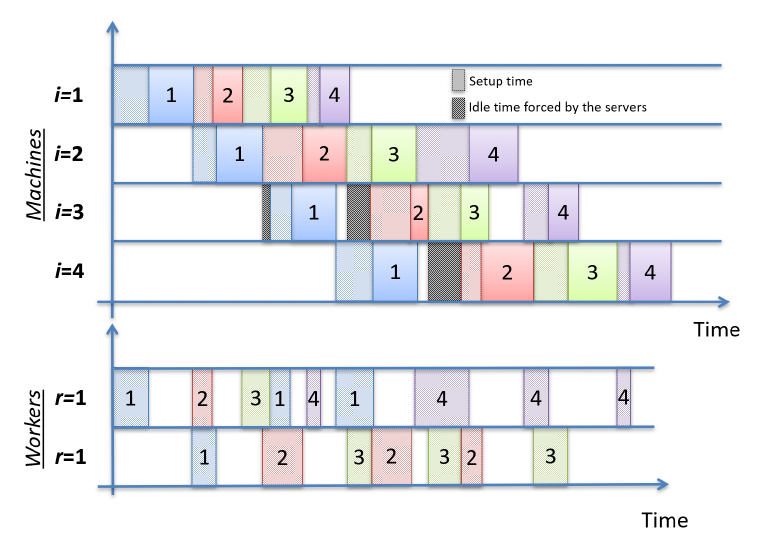
Figure 1. Example of the Fm , Sr | prmu , s ij | C max